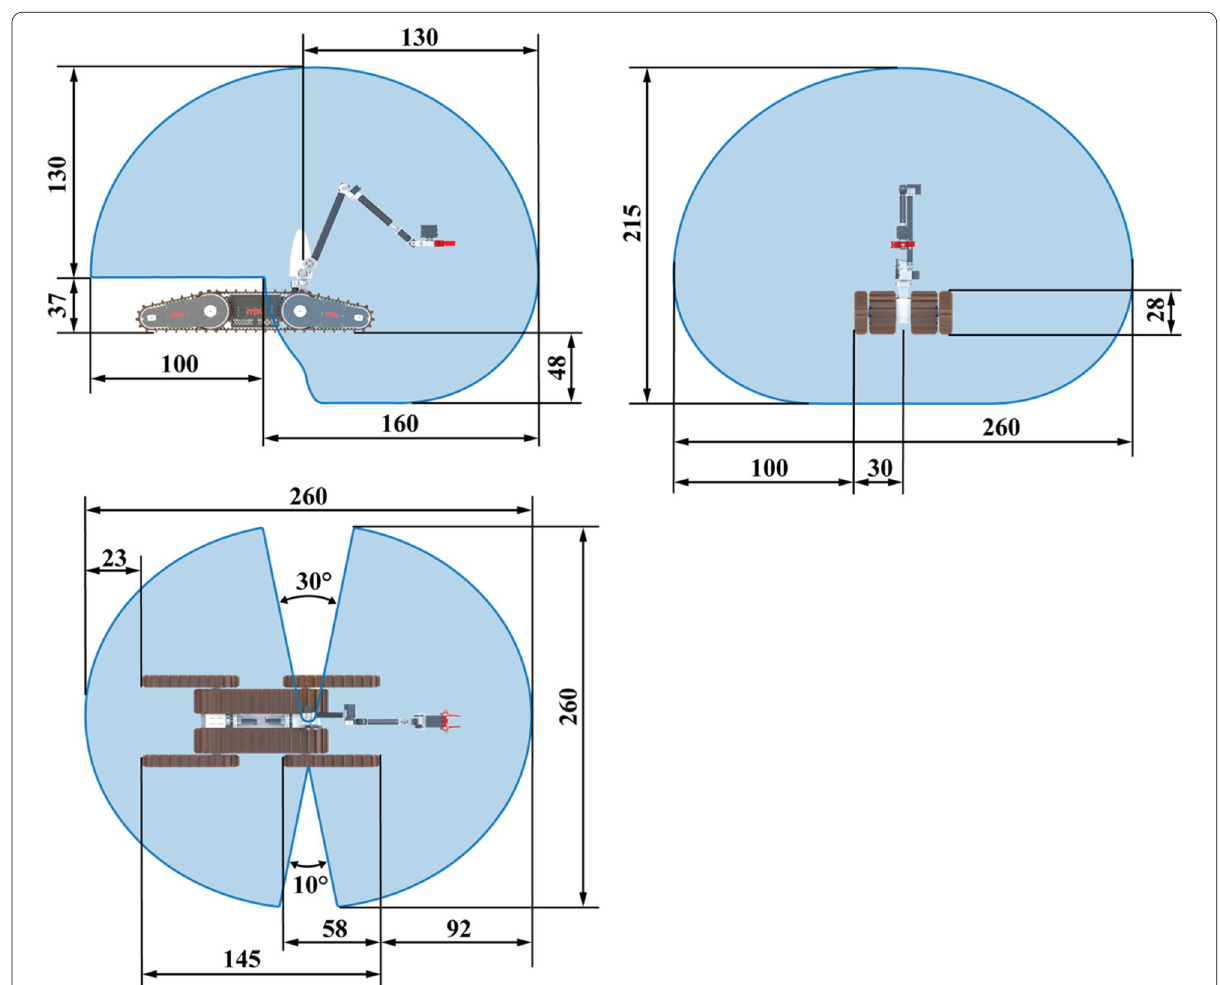
Fig. 11 The workspace of manipulator from left, front, and top view orientation (all dimensions are in